Question: Compose a caption that would accompany this figure in a paper.
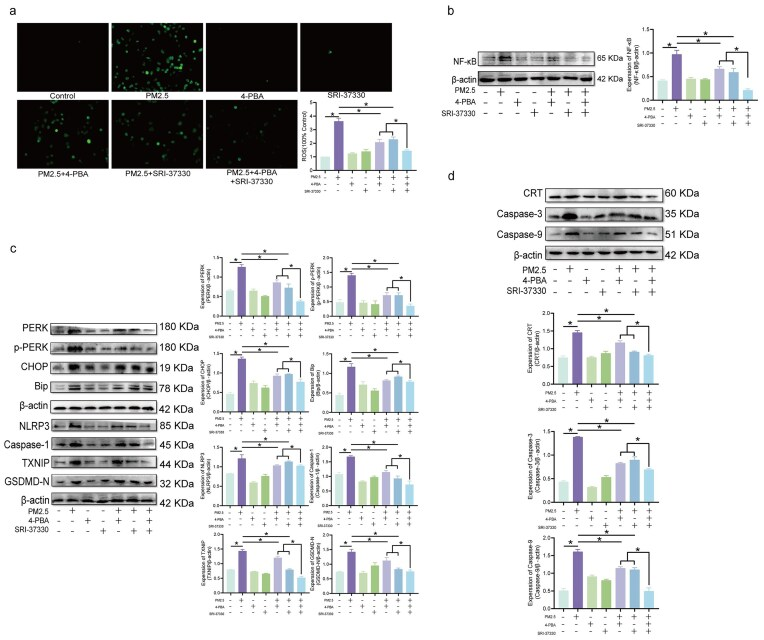
Answer: ERS and TXNIP play a key role in pyroptosis and apoptosis in H9c2 cells caused by PM 2.5 exposure. The classic inhibitors of ERS and TXNIP, 4-PBA and SRI-37330, were added to H9c2 cardiomyocytes, which were treated for 24 h. The following parameters were assessed: (a) changes in ROS levels across different groups (scale bar: 50 μm), (b) alterations in NF-κB protein expression, and (c) variations in the expression levels of ERS-related proteins (PERK, p-PERK, CHOP, and Bip), TXNIP, and pyroptosis-associated proteins (NLRP3, Caspase-1, and GSDMD-N). And (d) the changes in the expression levels of CRT, Caspase-3, and Caspase-9 proteins. The data shown as mean ± SD ( n = 3). ns, P ≥ .05; * P < .05.